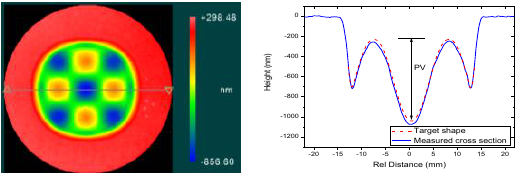
Fig. 3. Interferometric measurement of a test structure on N- BK7 and corresponding horizontal cross section (blue: measured, dotted red: target